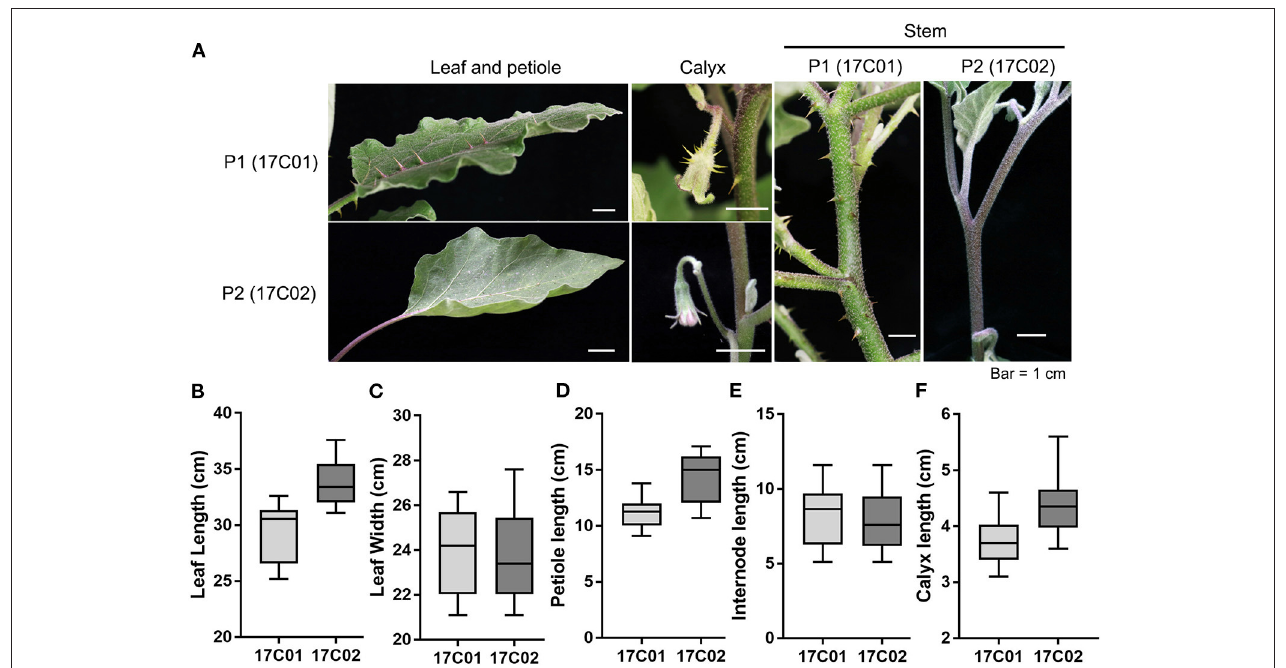
FIGURE 1 | The prickle characteristics of 17C01 and 17C02 on stem, leaf, petiole, and calyx. (A) The apparent prickles were observed on leaf, petiole, calyx, and stem in 17C01, while few could be observed in 17C02. The length and width of leaf, petiole length, internode length, and calyx length of 17C01 and 17C02 are shown in (B–F) , respectively. At least 15 seedlings were selected to be measured at the fruiting period. The largest leaf was chosen to measure the leaf length, leaf width, and petiole length. The length of internode between the first and second branches and the calyx length 15 days after pollination were